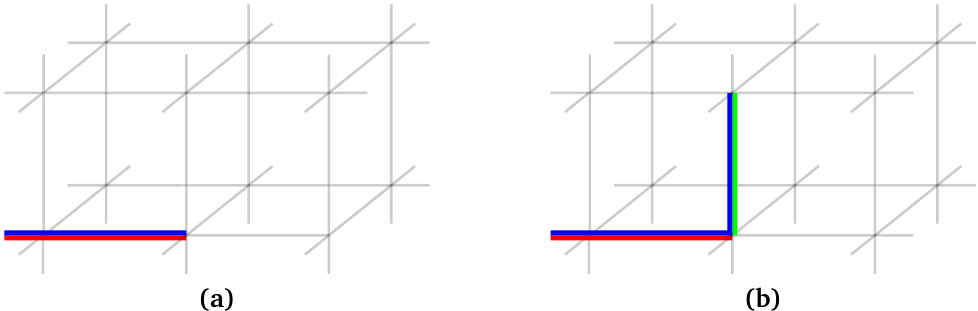
Figure 5: (a) A lineon excitation: two different-colored strings that end at a point. (b) The lineon can only move in a straight line since if its path bends, another lineon excitation is left behind at the corner. This occurs because the red string cannot follow the blue string in the z -direction as the red string is not allowed on edges in the z -direction. The green string is then necessary to avoid excitations of the edge term [ Eq. (19) ] . But an excitation remains at the corner since the red and green strings both have endpoints